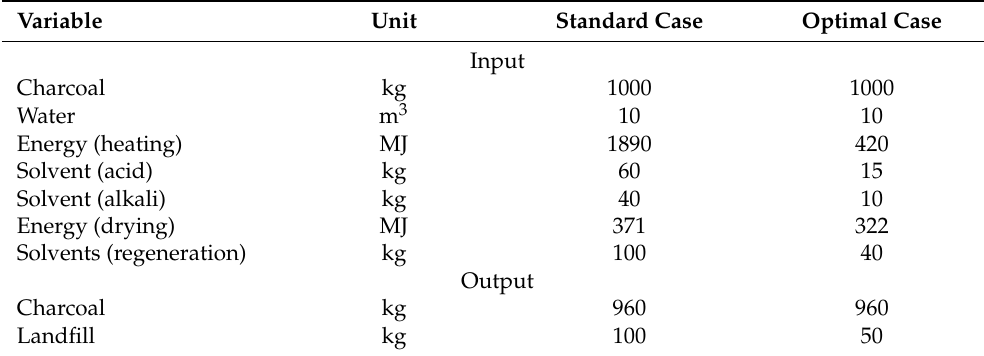
Table 3. Input parameter used for ash removal from